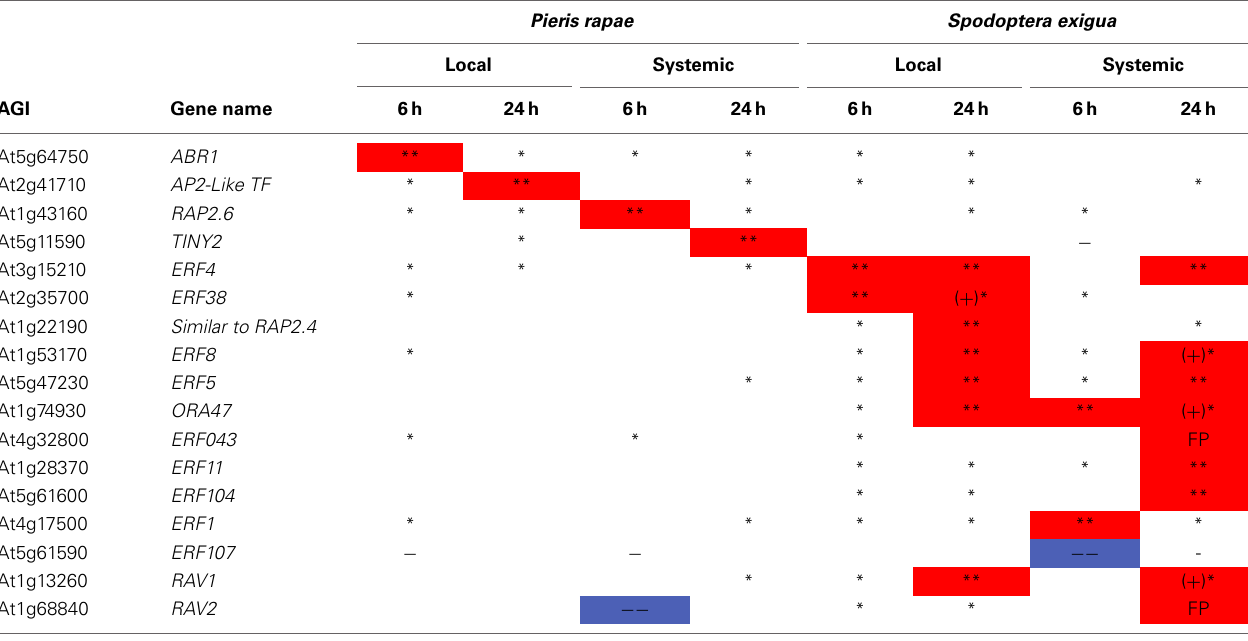
Table 1 | qRT-PCR confirmation of AP2-ERF transcription factor genes identified by microarray analysis-ERF transcription factor genes affected by P. rapae and S. exigua in the array were amplified and quantified using qRT-PCR.